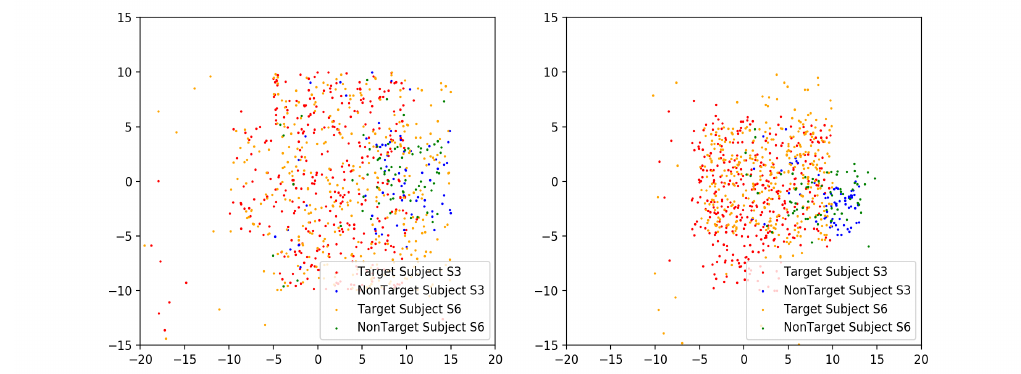
Figure 9. SPD covariance matrix of Subjects S3 and S6 before affine transformation of Dataset II ( left ); and SPD covariance matrix of Subjects S3 and S6 after affine transformation of Dataset II ( right